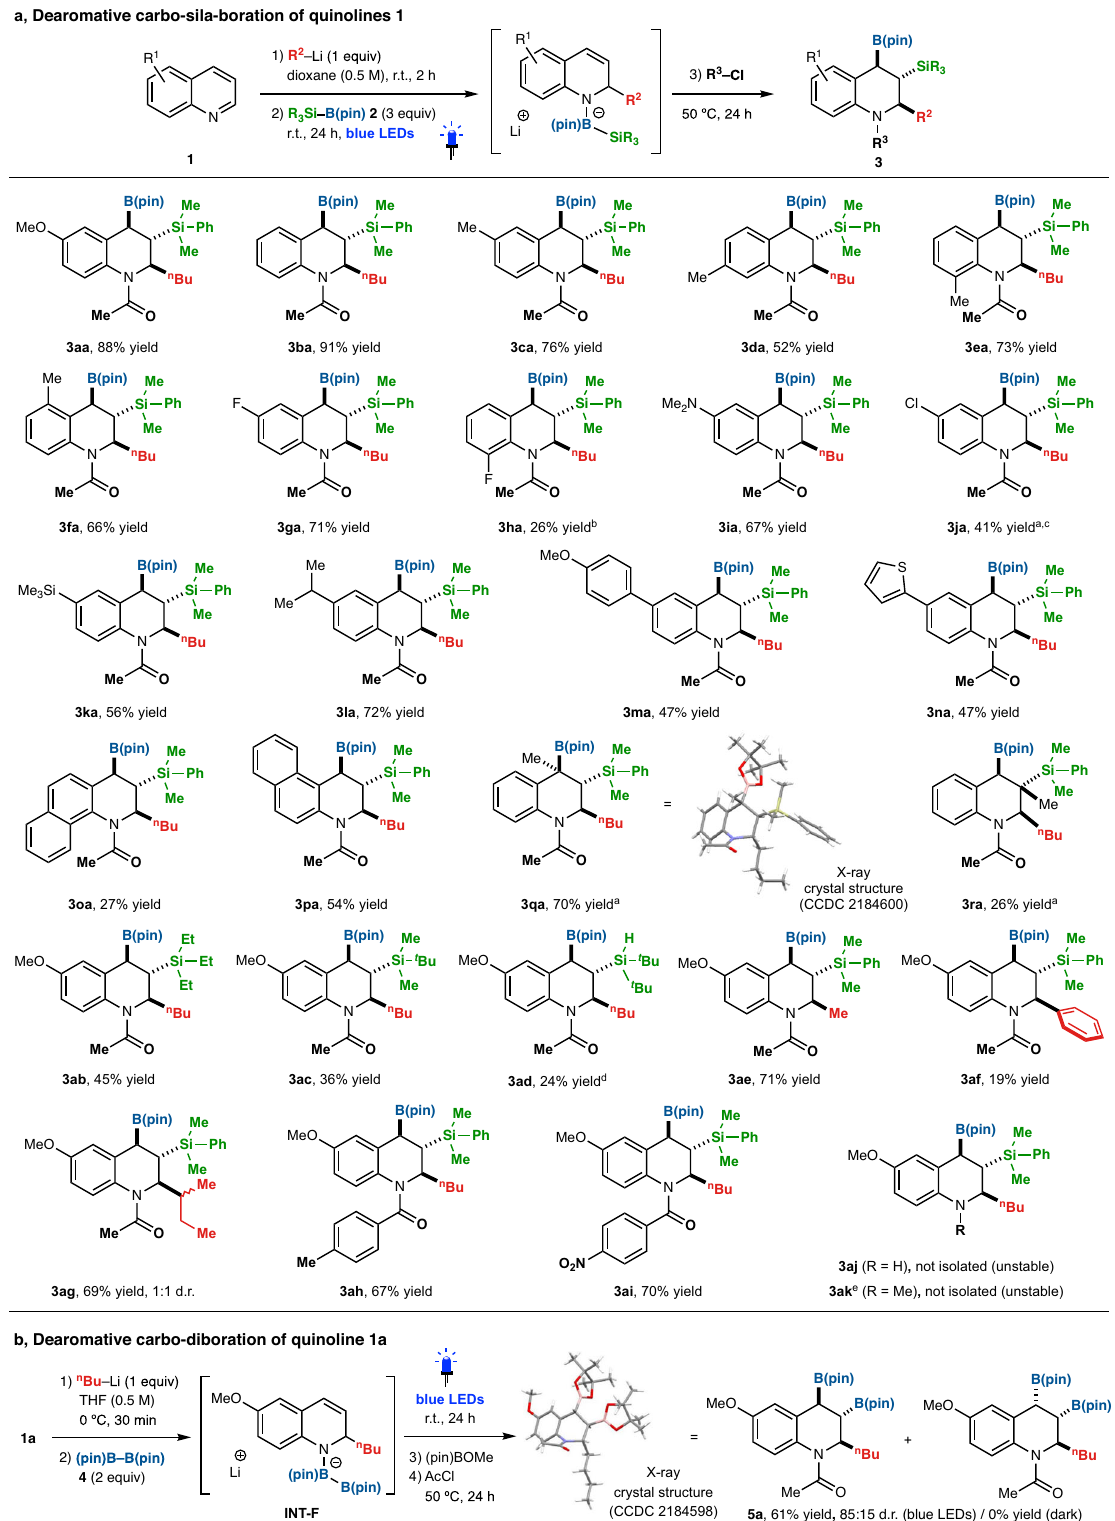
Fig. 3 | Dearomative triple elementalization ofquinolines. a Synthesis of carbo- sila-borated tetrahydroquinolines. b Synthesis of carbo-diborated tetra- hydroquinoline. Reactions were performed on a 0.25mmol ( 1 ) scale under argon. N – Functionalization using R 3 Cl was performed at 50 – 80°C until the reaction